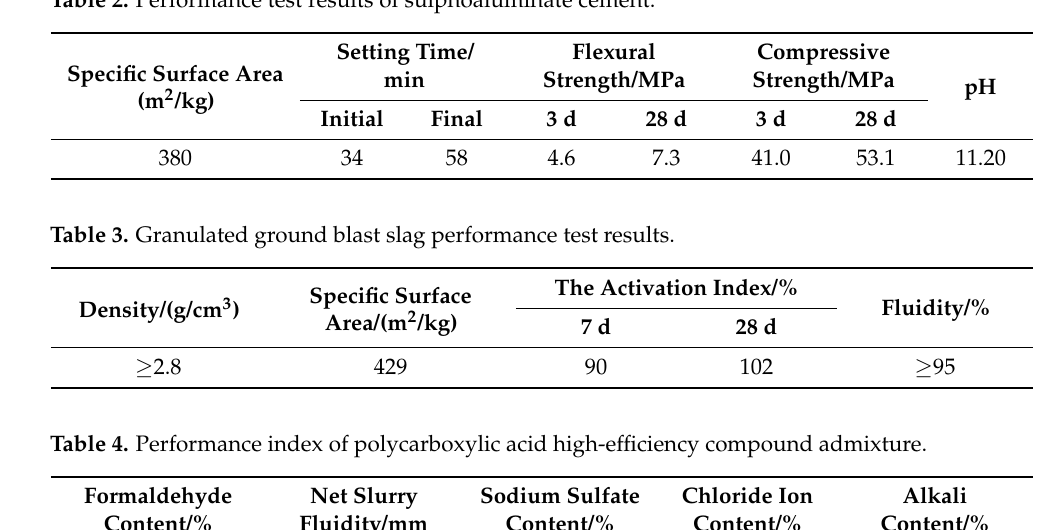
Table 2. Performance test results of sulphoaluminate cement.